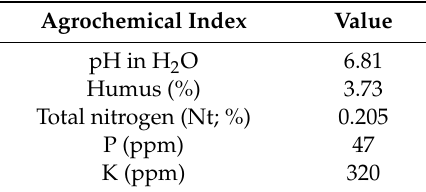
Table 1. Soil characteristics in the experimental site 1 .